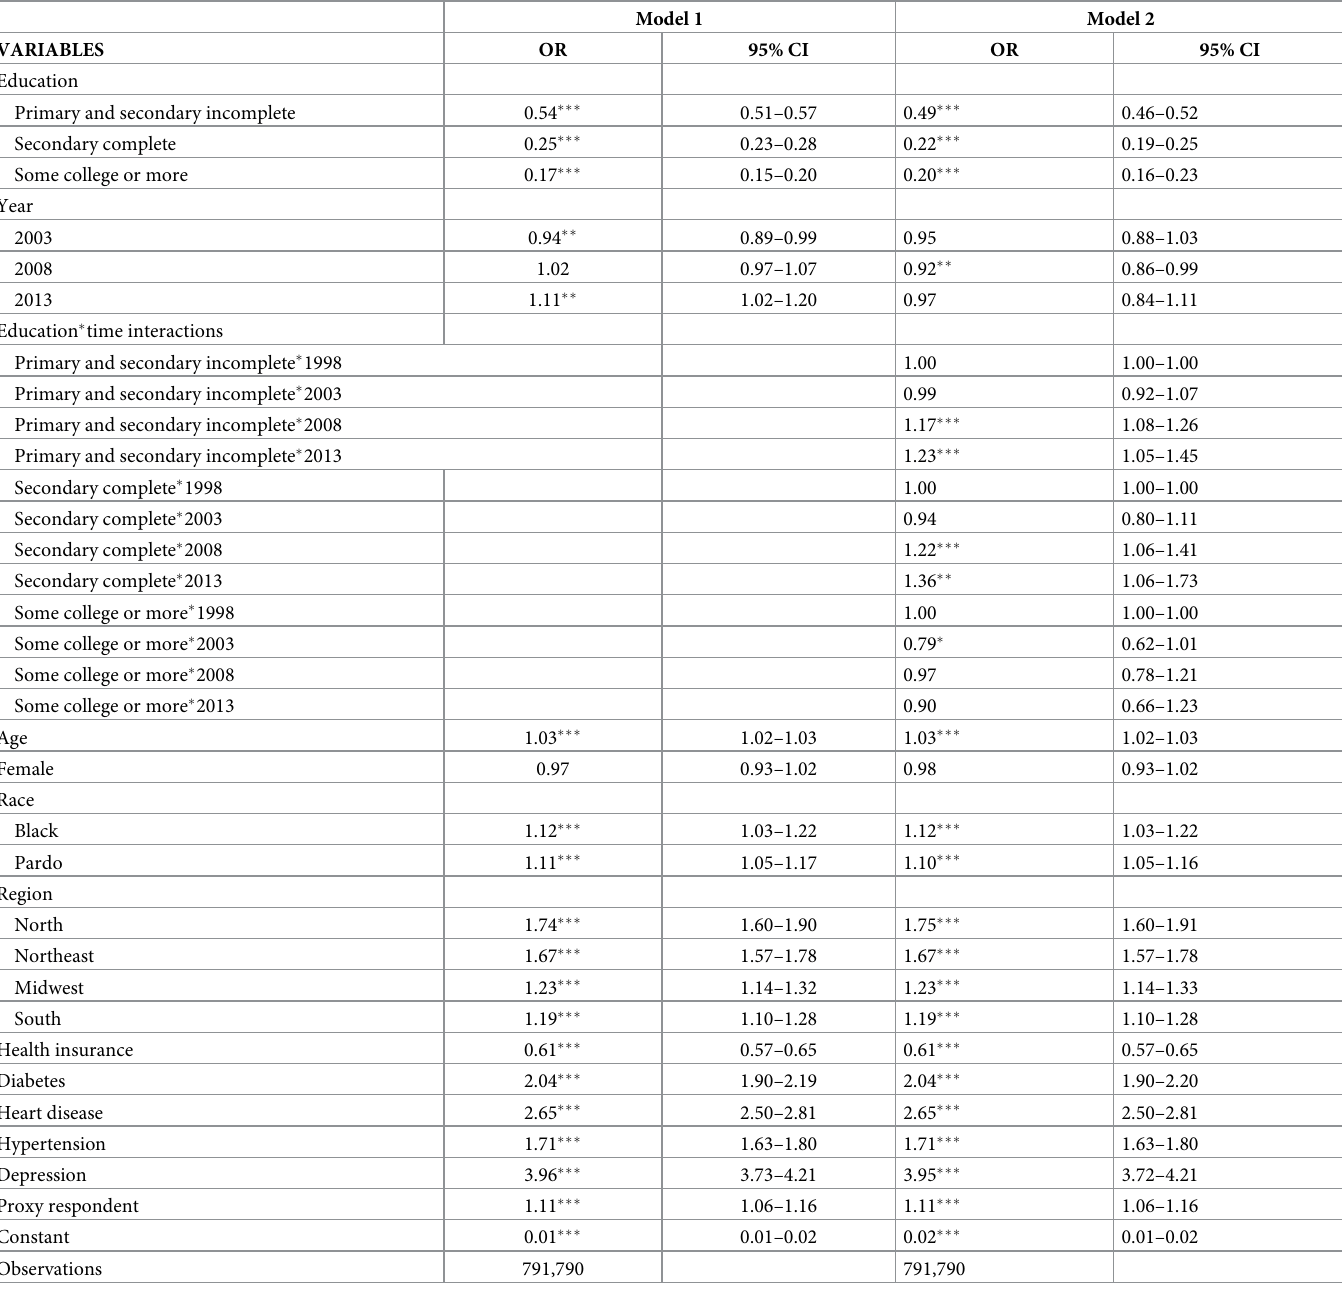
Table 4. Odds-ratios and 95% confidence intervals examining the association between educational levels and poor self-rated health over time, Brazil: